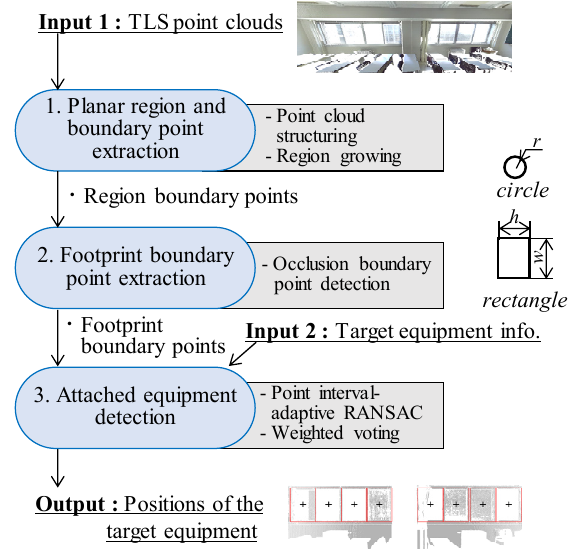
Figure 1. Flow of the attached equipment detection method